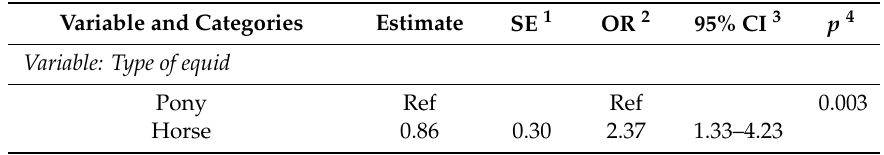
Table 11. Results of multivariate logistic regression analysis of associations between injury and